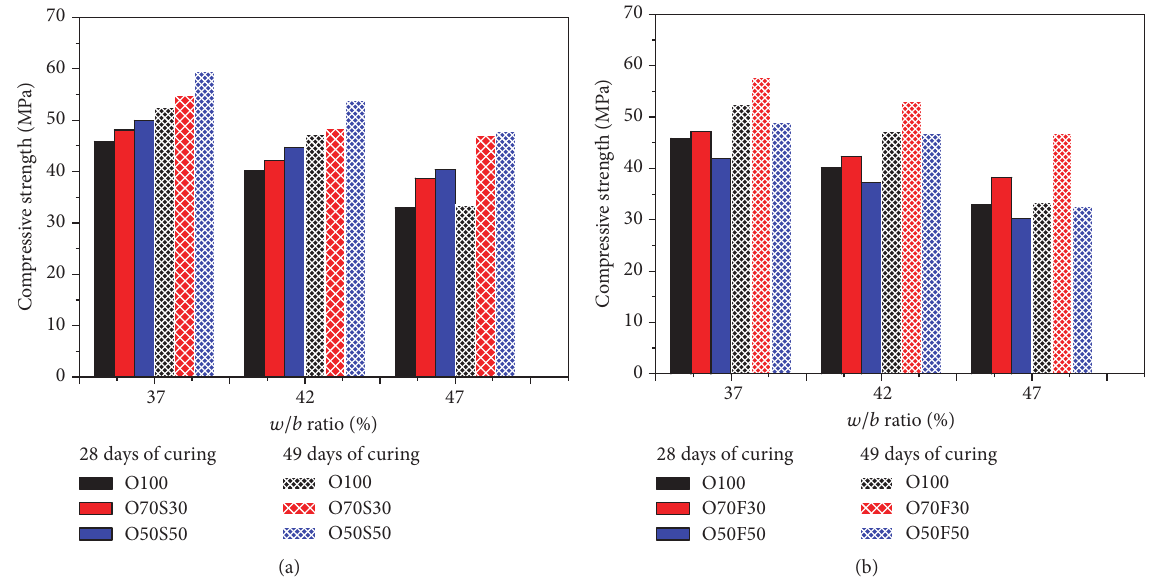
Figure 2: Compressive strength of HPC with (a) GGBFS and (b) FA at 28- and 49-day curing